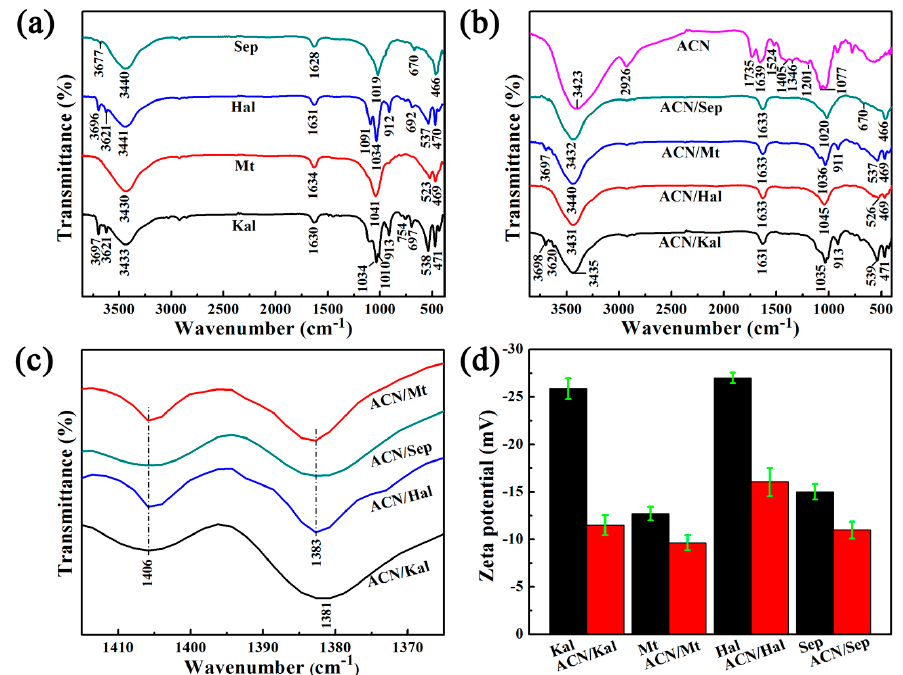
Figure 2. FTIR spectra of ( a ) the raw clay minerals, ( b ) ACN / clay mineral hybrid pigments and extracted ACN, ( c ) the partial enlarged view of above hybrid pigments, and ( d ) Zeta potentials of the raw clay minerals and hybrid pigments.